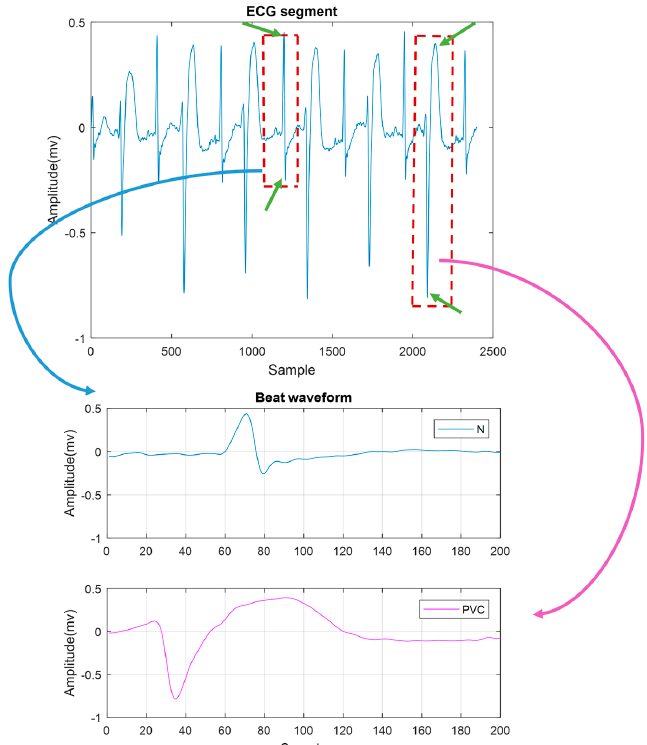
Figure 9. The segment on the top contains a bigeminy episode. On the bottom, the zoomed beats of normal (N) beat (in blue) and PVC (in purple) are shown. The local maxima and minima difference (LMMD) in the PVC beat is much higher than in the N beat. The peaks which we used to calculate LMMD are marked as green arrows.